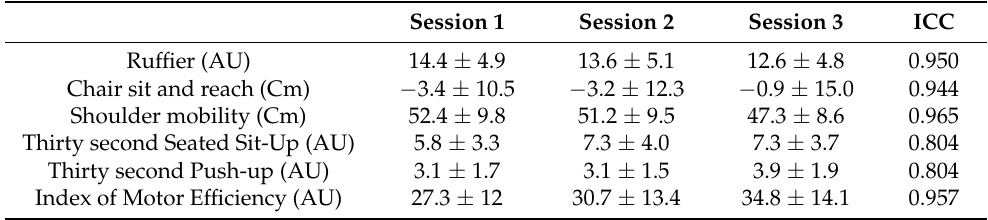
Table A1. Reliability results of the CFT.